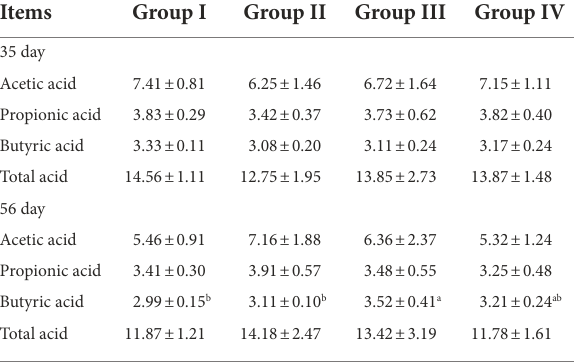
TABLE 8 Effects of different levels of FGSM on cecal SCFAs ( μ